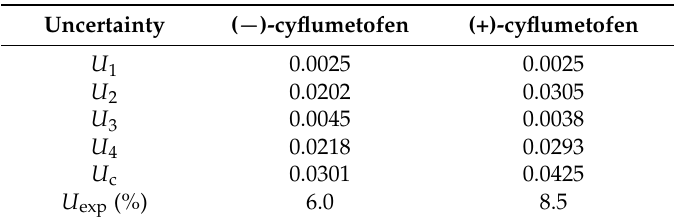
Table 1. Uncertainty ( U c ) and expanded uncertainty ( U exp ) in apple matrices for (−)-cyflumetofen and (+)-cyflumetofen at 50, 500, and 1000 μg/kg.